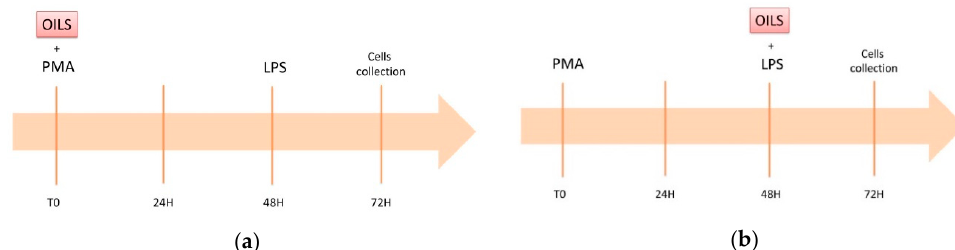
Figure 1. Graphical representation of the two different experimental settings: ( a ) SET1, exposure to oils (NG or EVO) occurs from the beginning of the differentiation; ( b ) SET2, exposure to oils (NG or EVO) occurs at the time of inflammation induction with lipopolysaccharides (LPS).